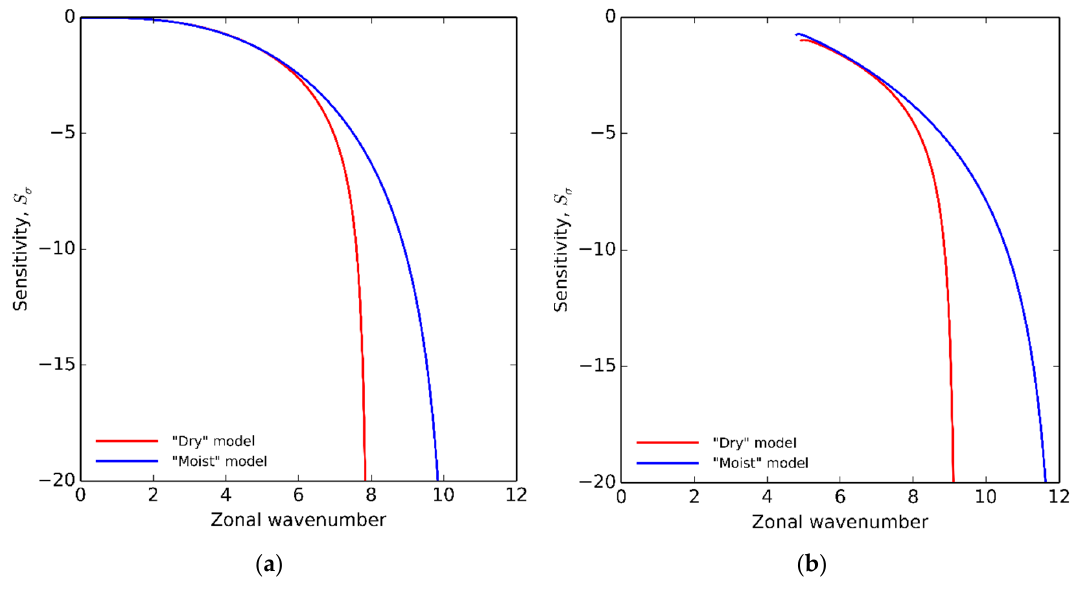
Figure 2. Sensitivity functions S σ with respect to the static stability parameter as functions of the zonal wavenumber k z for the “dry” and “moist” ( a ) f -plane and ( b ) β -plane models. Table 2. Absolute and relative sensitivity functions for the most unstable wave obtained from the f -plane and β -plane